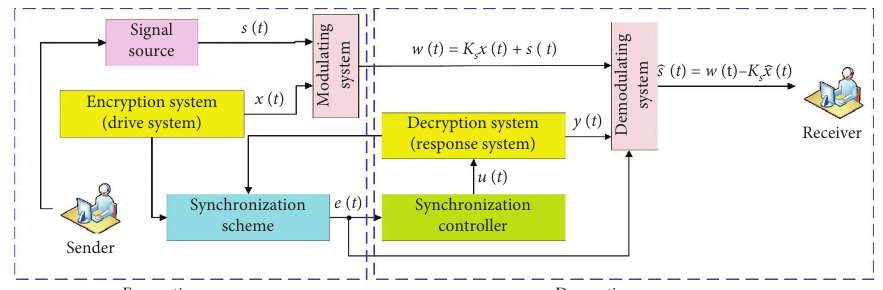
Figure 7: Framework of the chaotic secure